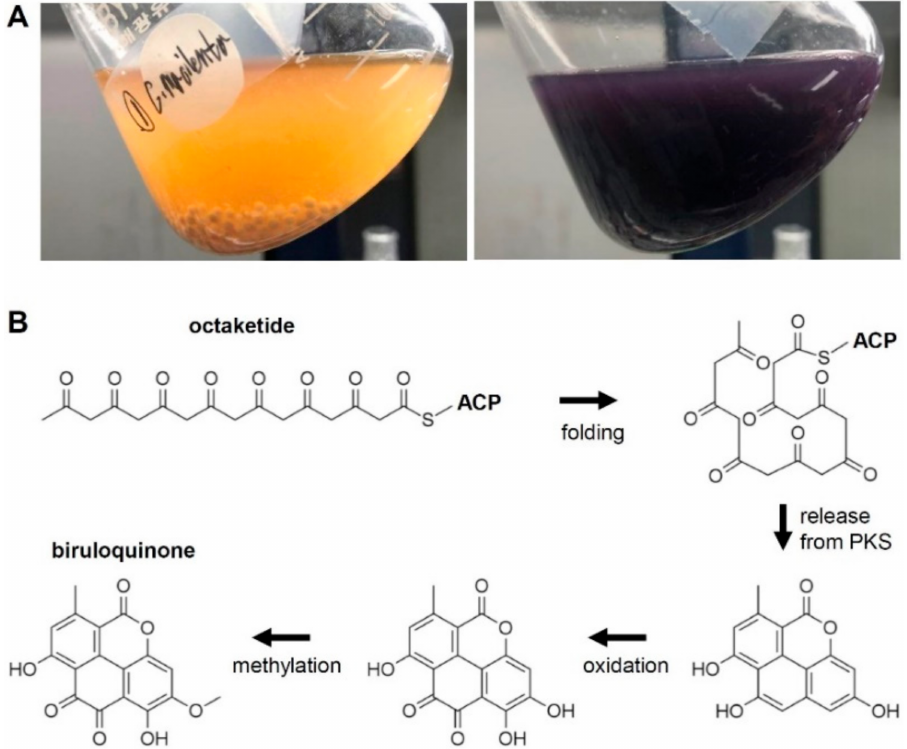
Figure 1. Production of biruloquinone. ( A ) Accumulation of biruloquinone (purple pigment) in an axenic culture of Cladonia macilenta LFF (right panel). Left panel shows an axenic culture of C. macilenta LFF devoid of biruloquinone. ( B ) A proposed polyketide pathway for the biosynthesis of